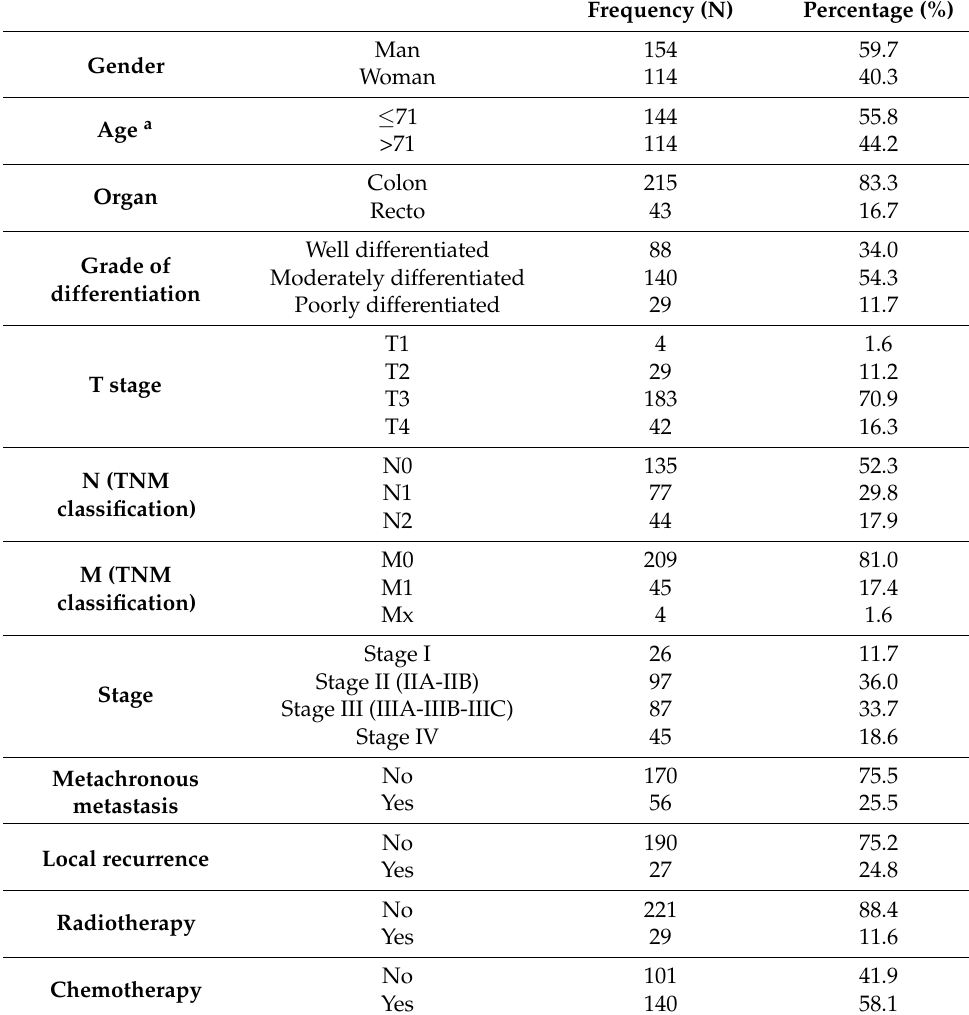
Table 1. Characteristics of patients included in the